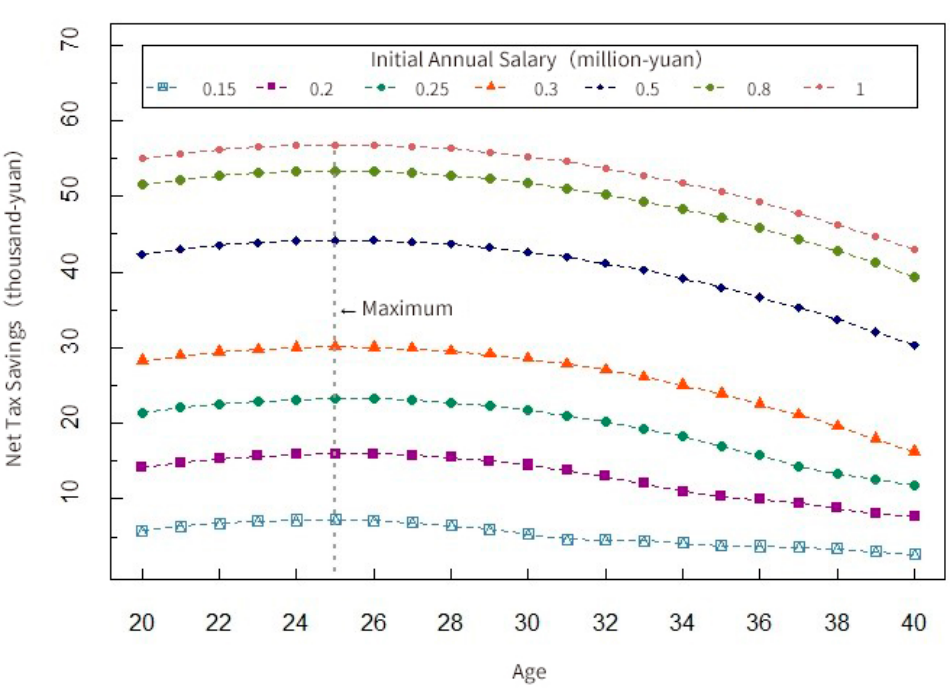
Figure 3. Changes in NTS for women at di ff erent insured ages.